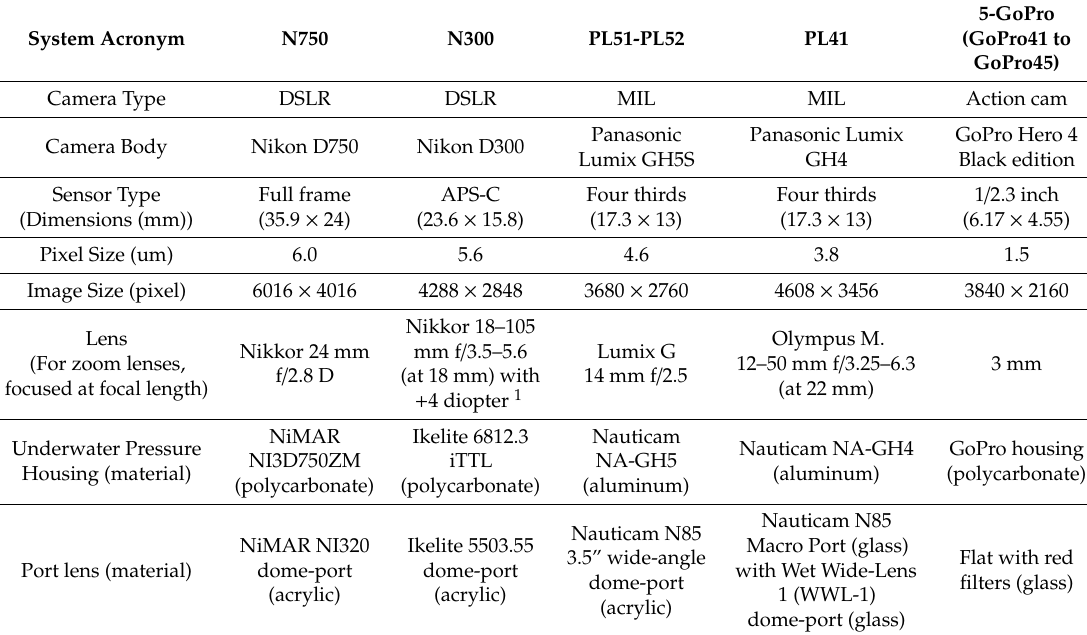
Figure 6. The tested underwater photogrammetric systems. Table 2. Characteristics of underwater photogrammetric systems tested